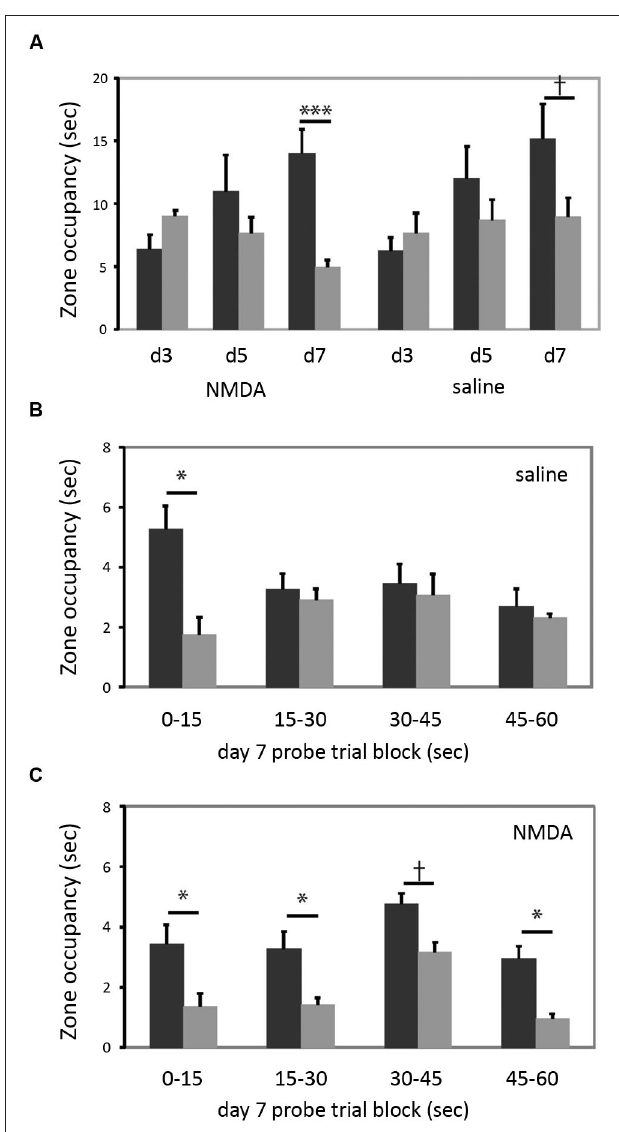
FIGURE 4 | DMS lesions do not impair cued learning. (A) Both lesioned and control mice ( n = 9 in each group) developed a bias towards the reinforced cue by the day 7 probe trial. When groups were analyzed separately for day 7 target zone occupancy, there was a highly significant difference in target zone occupancy in lesioned animals; the bias was present at trend level in control animals. (B) This quadrant bias was apparently only in the first 15 s of search in control animals; for the balance of the probe trial they searched more broadly. Quadrant bias was significant during the first 15 s ( p < 0.05) but non-significant during all other blocks (all p > 0.25). (C) In contrast, animals with DMS lesions showed a persistent goal-quadrant bias during all probe trial blocks. When examined separately, this bias was significant for blocks 1, 2, and 4, and at trend level for block 3. † p < 0.1; * p < 0.05; *** p <